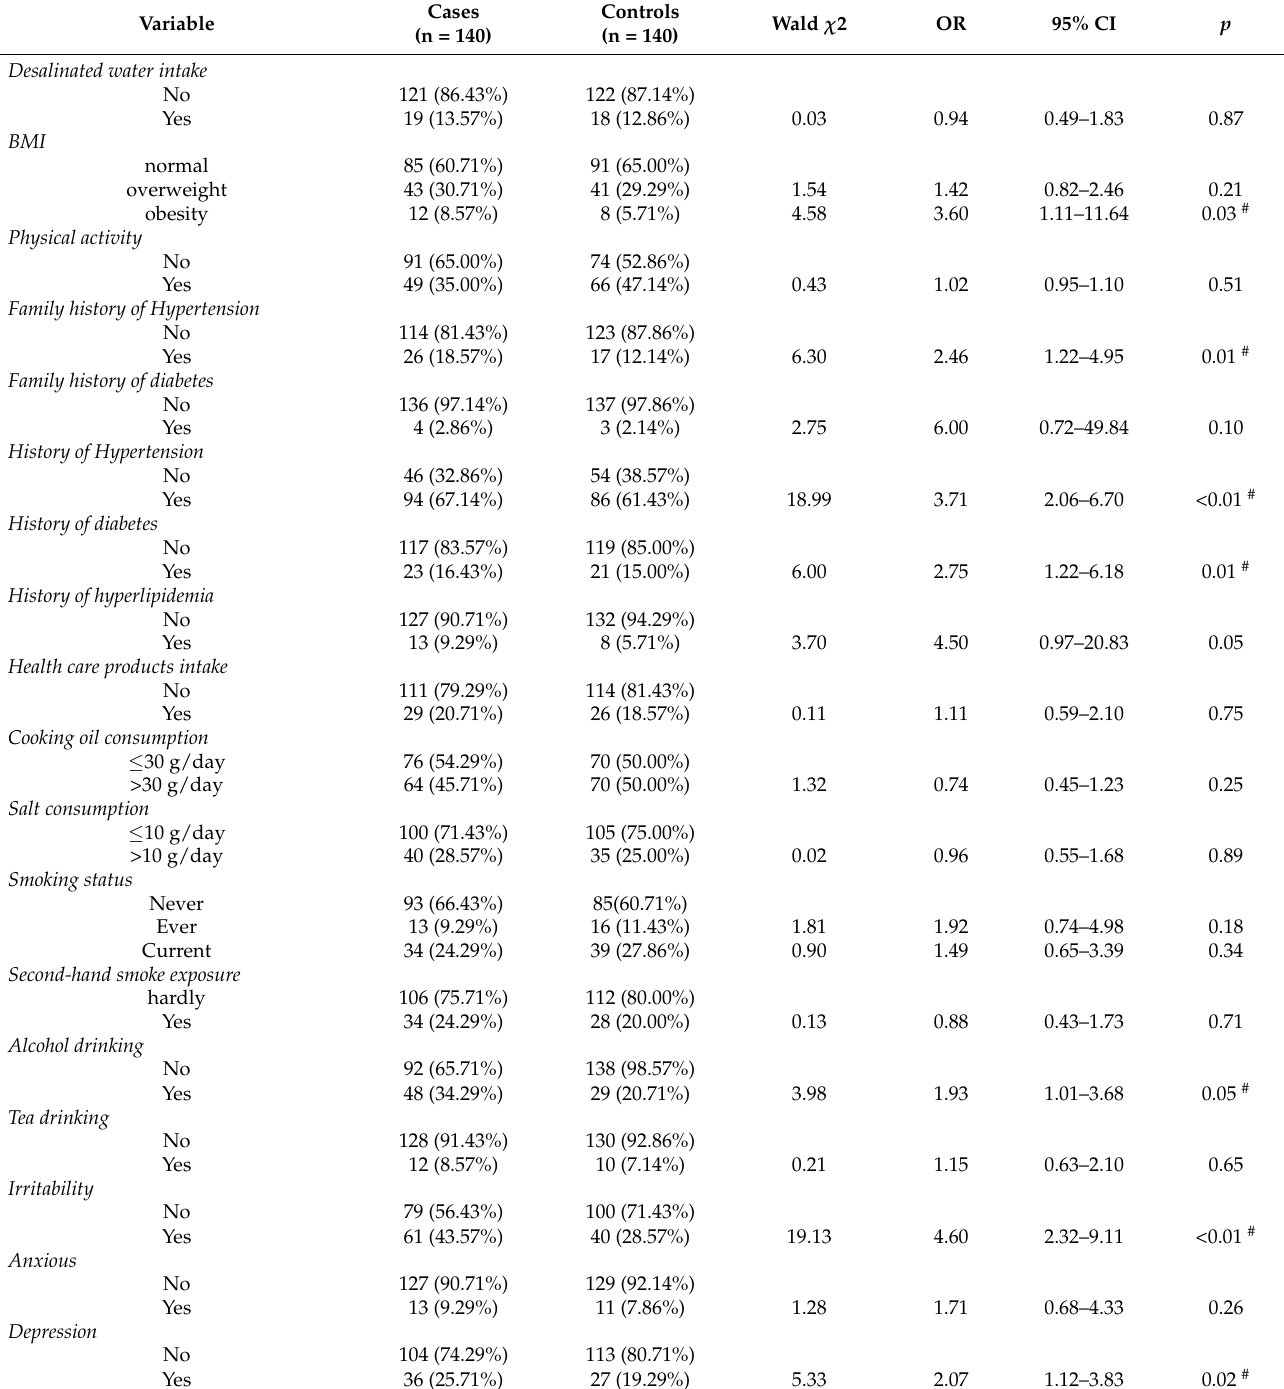
Table 6. Univariate analysis of CVDs factors